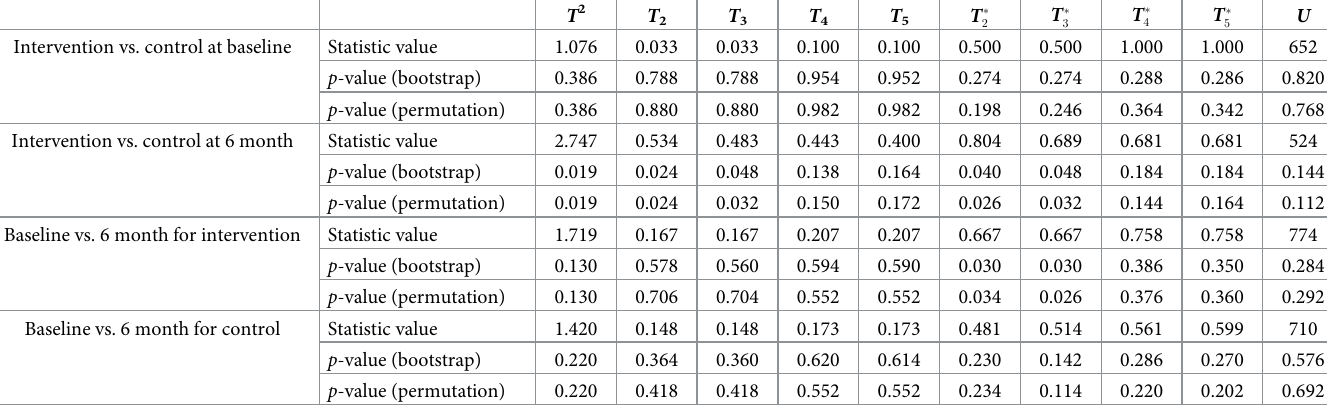
Table 7. Values of test statistics and corresponding p -values for comparison of intervention and control groups at baseline and 6-month visits and for comparison of baseline (upper panel) and 6-month visits within each group (lower